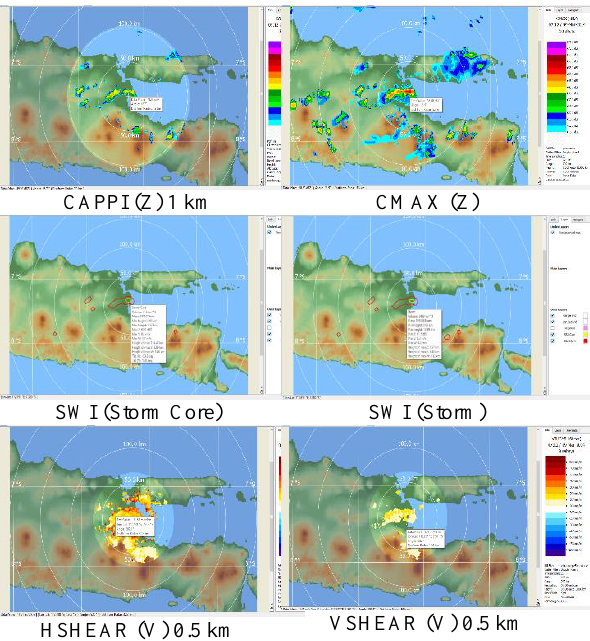
Figure 6. Radar product at whirl wind occurence Sidoarjo,